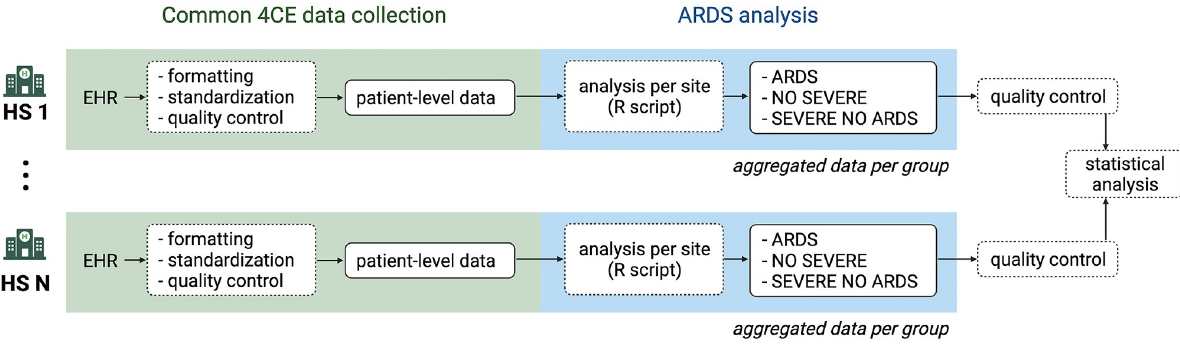
PLOS ONE | https://doi.org/10.1371/journal.pone.0266985 January 4,